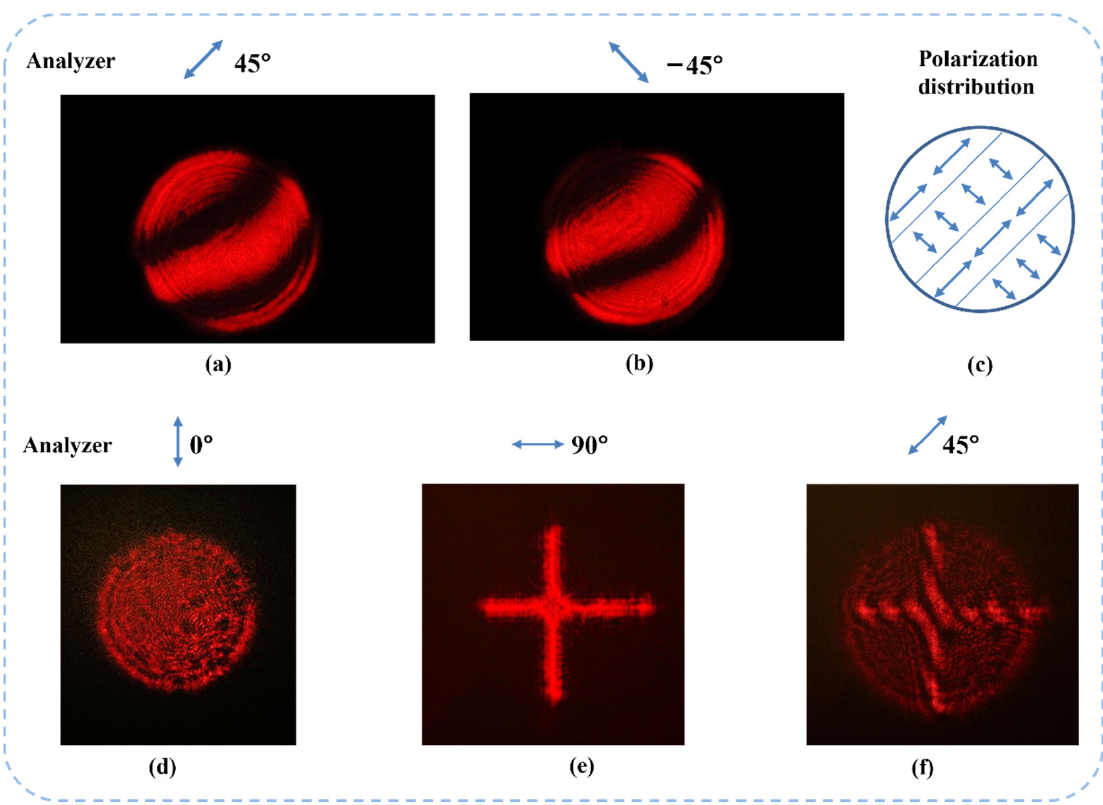
Figure 11. Interference patterns of two orthogonal vector beams with the same shape are observed when the analyzer is placed at 45 ◦ ( a ) and − 45 ◦ ( b ). The combined beam includes two original polarization states ( c ). ( d , e ) show the superposition of two orthogonal vector beams with different shapes (circle and cross) that is observed under different polarization analyzer angles (blue double- end arrow). Interference patterns are observed when the analyzer is placed at 45 ◦ ( f